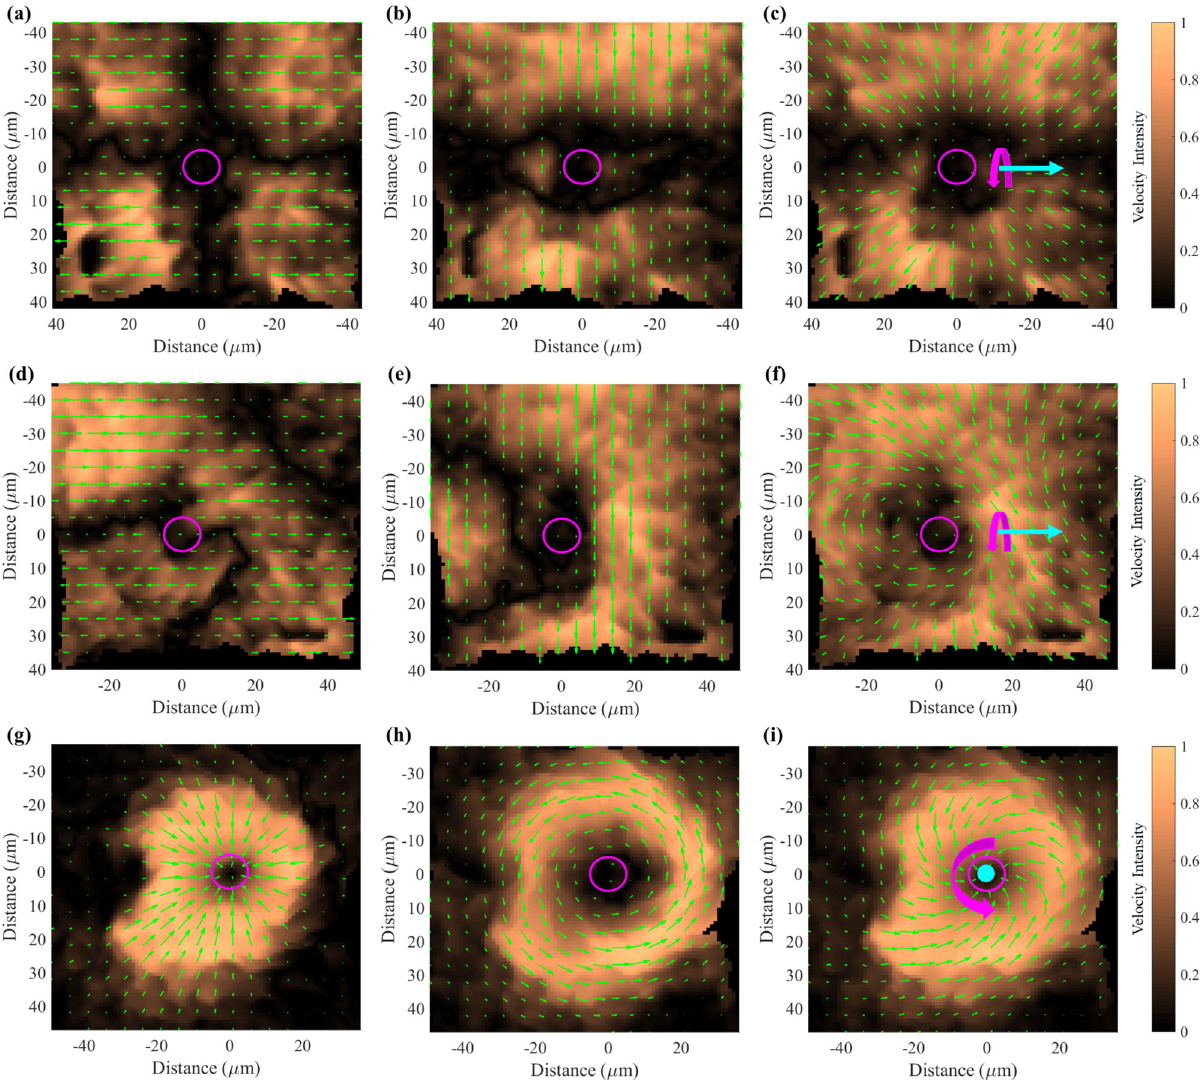
Fig. 4 μ PIV in x – y plane of microparticles in 4% mucin. The ( a ) propulsion direction, ( b ) transverse direction, and ( c ) total velocity fl ow fi eld for a microparticle not propelling. The ( d ) propulsion direction, ( e ) transverse direction, and ( f ) total velocity fl ow fi eld for a microparticle that is propelling. The ( g ) radial, ( h ) azimuthal, and ( i ) total velocity fl ow fi eld for a microparticle propelling away from the substrate (positive z -direction). Inward radial fl ow is consistent with secondary fl ows generated by hoop stresses. All μ PIV experiments were performed close to the boundary (<100 µ m, see Methods). Cyan arrows represent propulsion direction and magenta arrow represents rotation direction. Magenta circle is the microparticle. Color bars to the right represents percentage of velocity magnitude with respect to the maximum velocity magnitude. These experiments were repeated at least two other times and all results revealed similar pro fi les; the results in ( g – i ) were repeated in 0.25% polyacrylamide and can be found in Supplementary Note